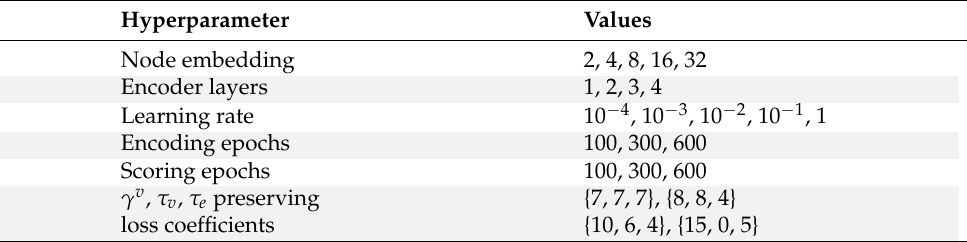
Table 2. Hyperparameter values tested during our grid search for DDEGK graph